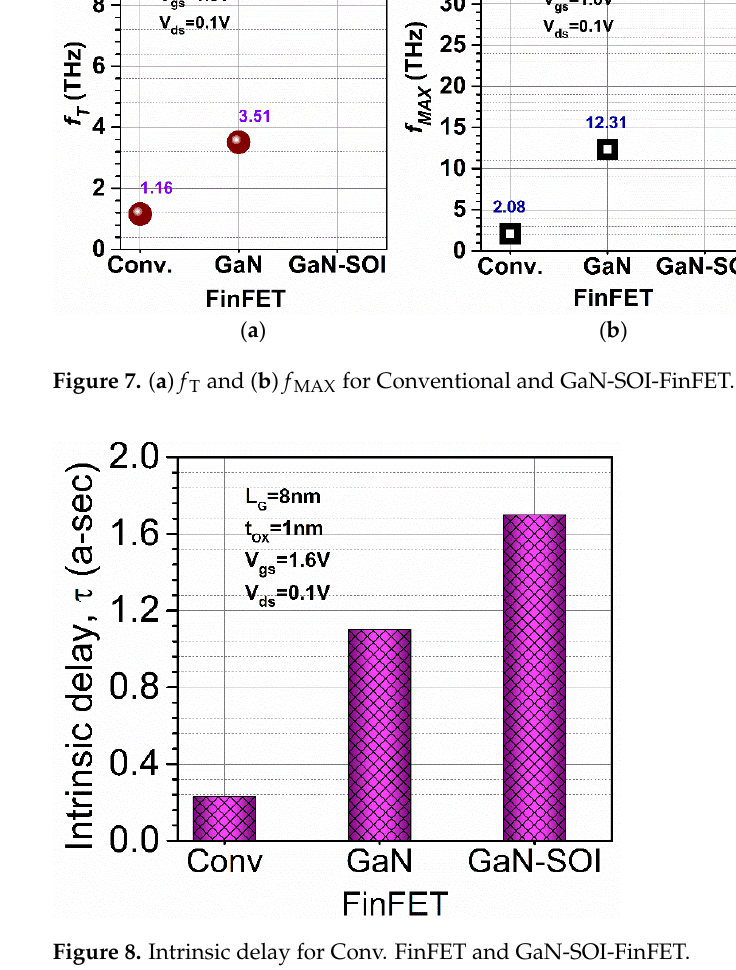
Figure 8. Intrinsic delay for Conv. FinFET and GaN-SOI-FinFET.